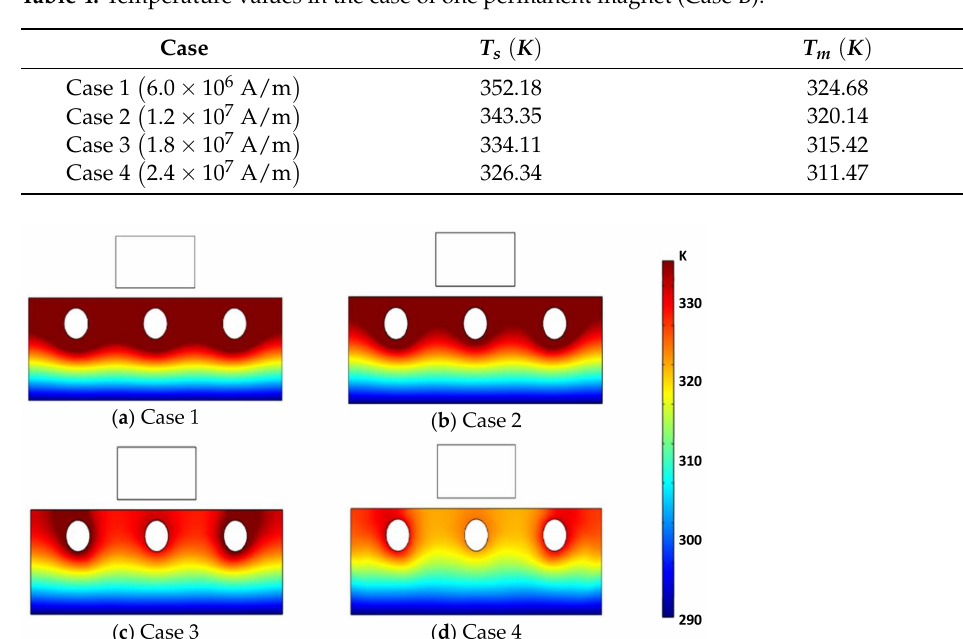
Table 4. Temperature values in the case of one permanent magnet (Case B).